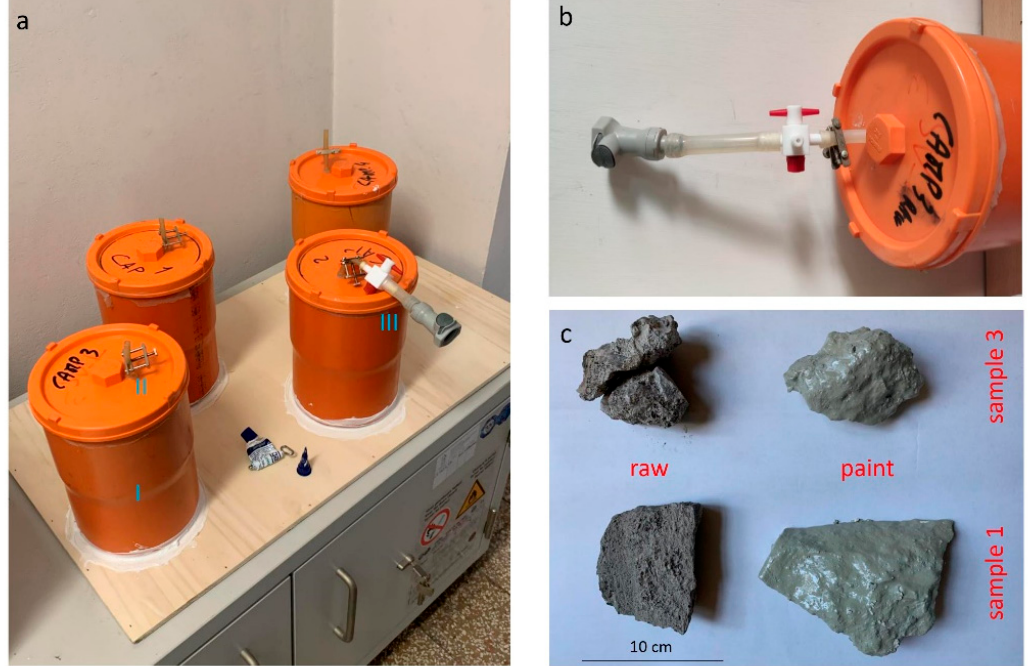
Figure 2. The cylindrical chambers, sealed at the base with silicon paste, inside which the synthetic materials were positioned ( a ); the connection between the internal part of the chamber and the Lumex RA-915M controlled by a hose clamp and a three-way valve ( b ); the selected samples (#1 and #3) used to compare the release of GEM (Gaseous Elemental Mercury) by the “painted” and unpainted (“raw”) materials ( c ).